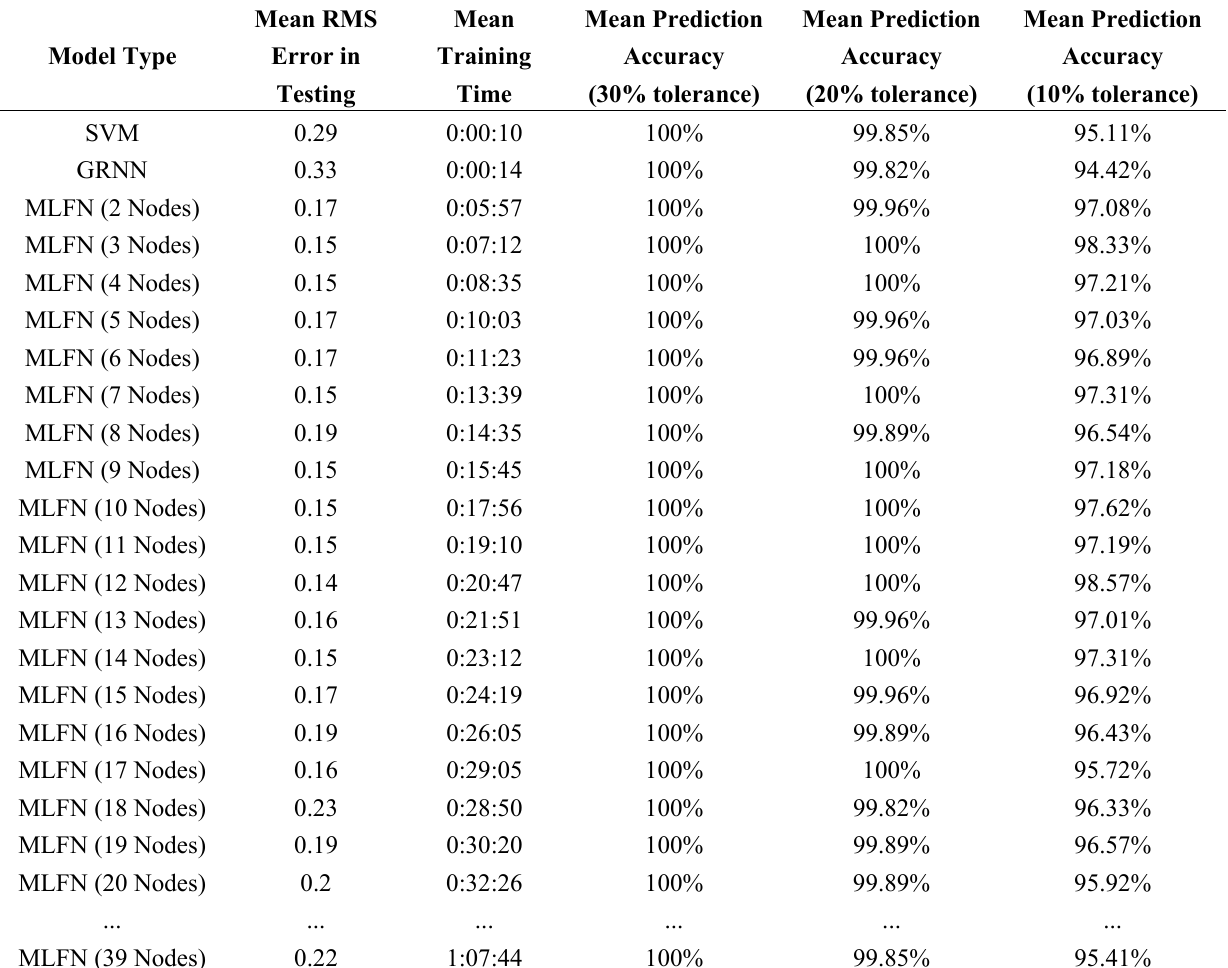
Table 3. Results of prediction models for heat collection